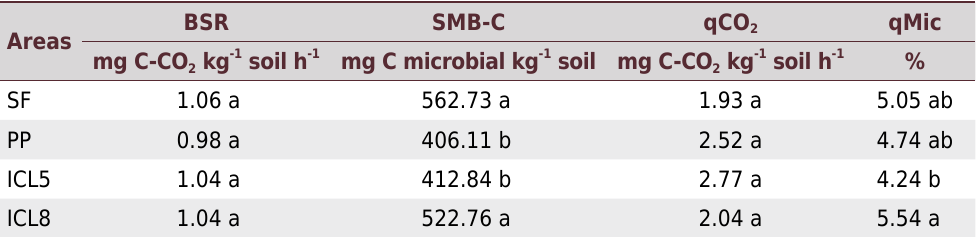
SF: Secondary Forest; PP: Perennial pasture; ICL5: Pasture recovered in integrated crop-livestock to five years; ICL8: Pasture recovered in integrated crop-livestock to eight years. Means followed by the same letter in the column do not differ by the t-test